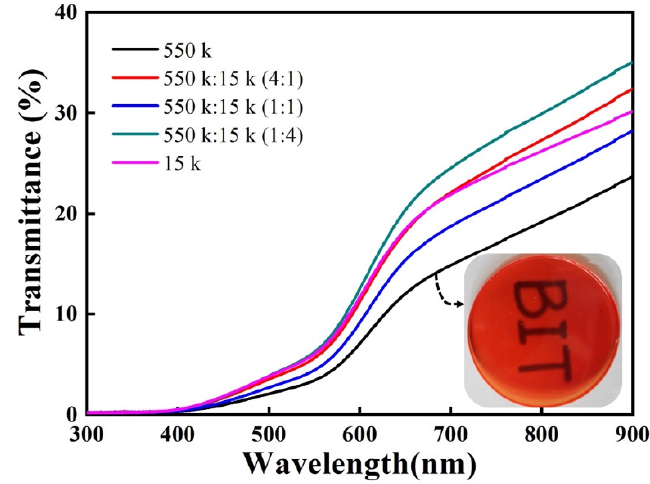
Figure 4. Transmittance spectra of red emissive composite films (20 wt% CuInS 2 NCs) prepared by blending PMMA with different molecular weights.